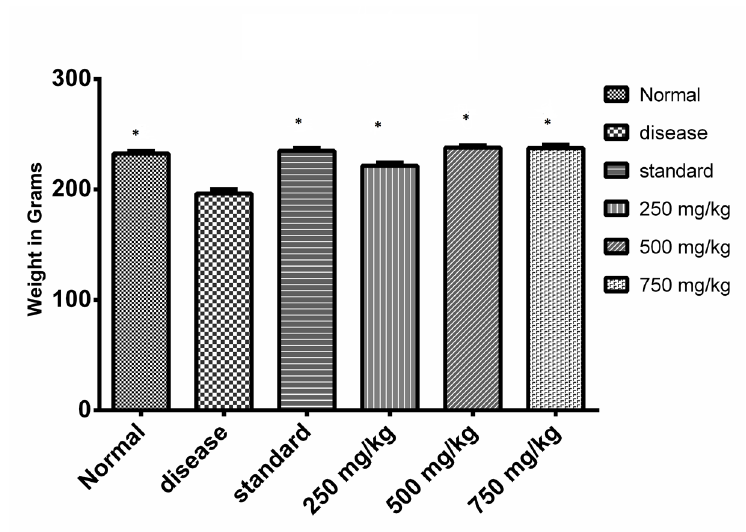
FIGURE 1 – Effect of M. neglecta extract pretreatment on blood glucose level (mg/dL) in Oral glucose tolerance test Where the values of blood glucose level were significantly different to disease control (p<0.05) at 120 min.